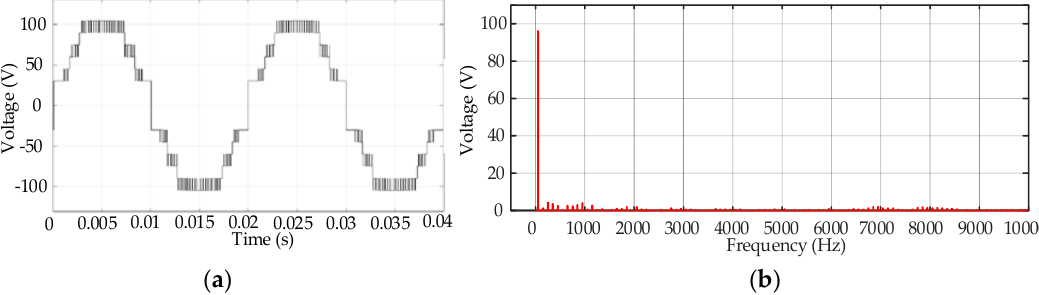
Figure 10. Output of the MLI in Mode II without the introduction of the zero level ( a ) Voltage waveform ( b ) its corresponding harmonics spectra. THD is 12.5%.